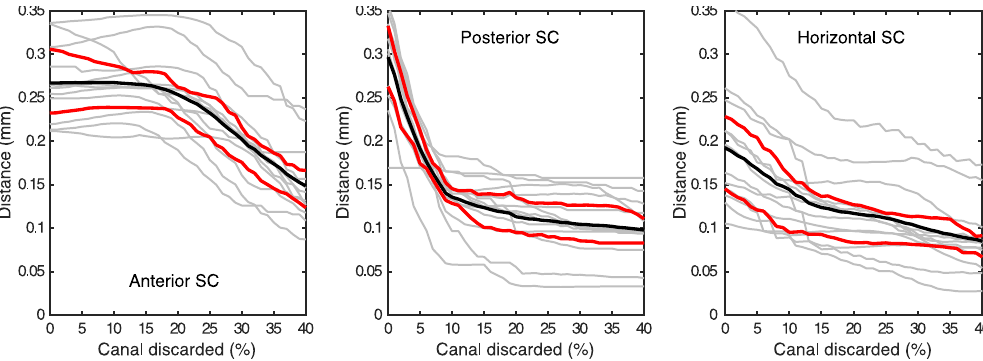
Figure 10. Standard deviation for the A, P and H plane separation from the reference plane as a function of the percentage of discarded SC. Grey lines represent different volunteers, the black line is the average and the red lines represent the limits for one standard deviation for each